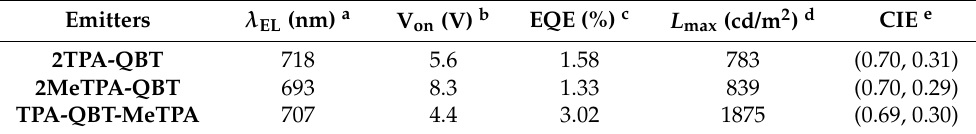
Table 3. Electroluminescence parameters for the three doped